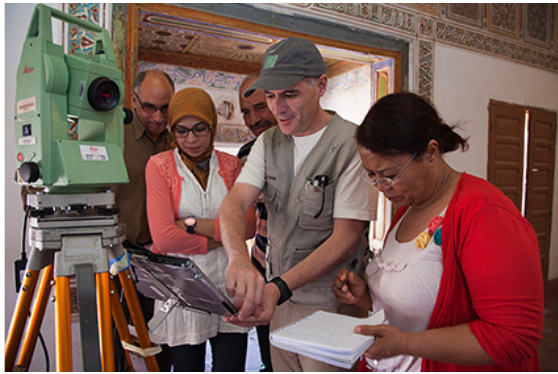
Figure 6: CIMS team training CERKAS experts on recording techniques, The Getty Conservation Institute.